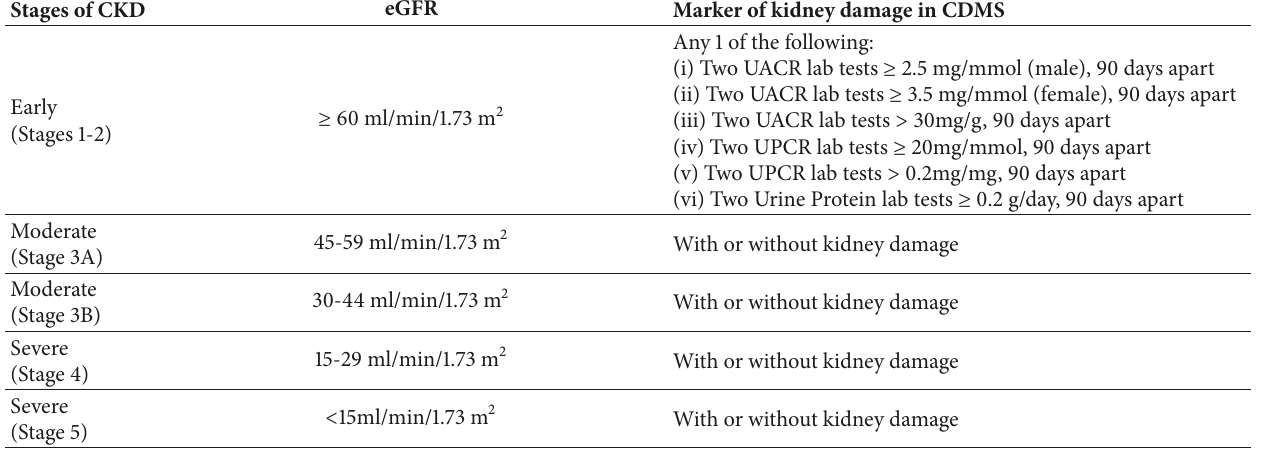
Table 2: Definition of CKD in the